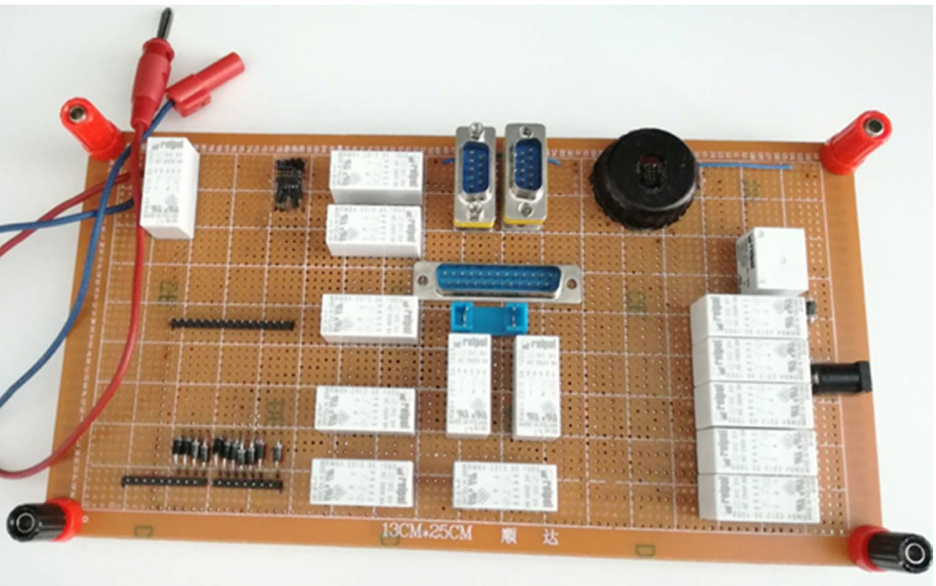
Figure 14. Radar interfacing